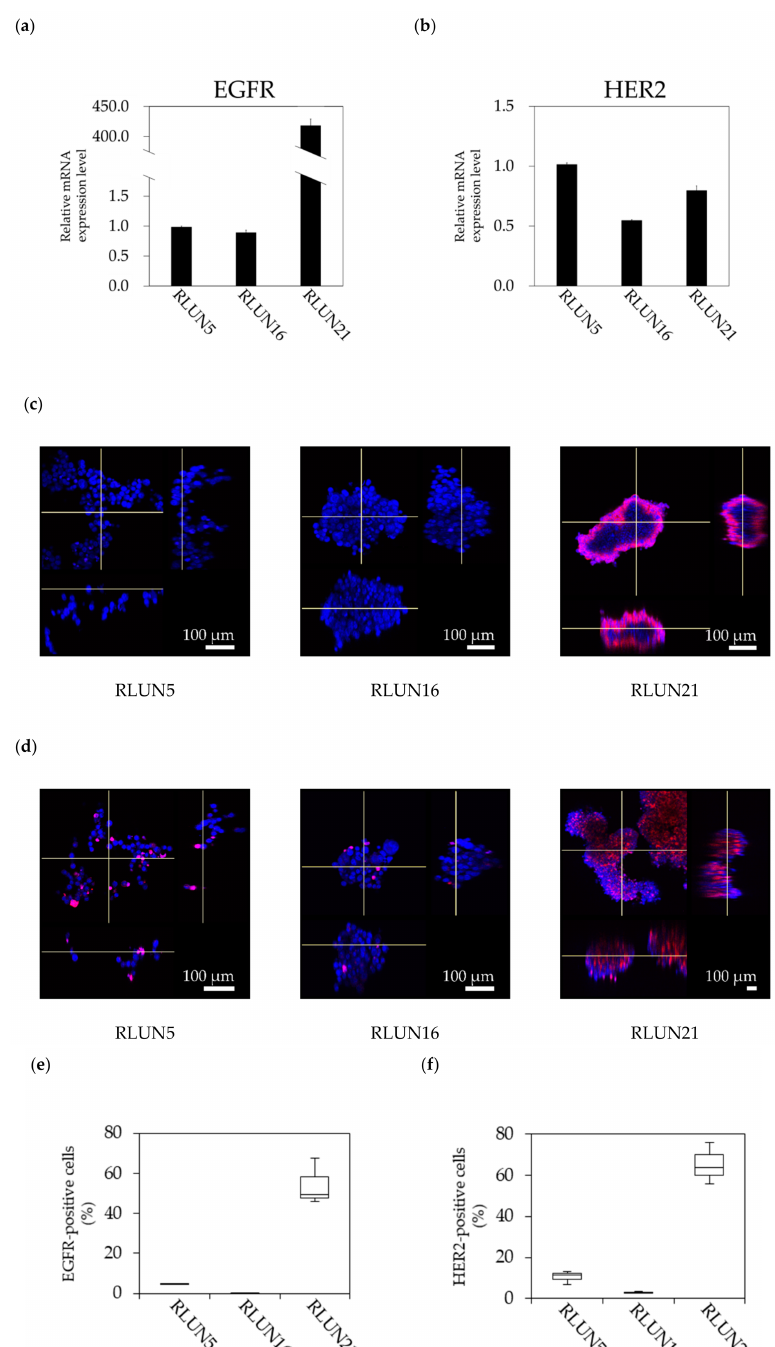
Figure 2. Expression of epidermal growth factor receptor (EGFR) and human epidermal growth factor receptor 2 (HER2) in three lung F-PDOs. mRNA-expression levels of ( a ) EGFR and ( b ) HER2 in RLUN5, RLUN16, and RLUN21. Gene-expression levels were normalized against that of 18S rRNA gene, using the 2 − ∆∆ Ct method. The expression data for RUNL16 and RUNL21 were normalized to those for RLUN5, which was set to 1. The error bars indicate the standard deviation from three replicate samples. ( c ) EGFR-expression images of RLUN5, RLUN16, and RLUN21 stained with fluorescently labeled cetuximab (red). ( d ) HER2-expression images stained with fluorescently labeled trastuzumab (red). DNA stained with DAPI (blue). Magnification: × 10. Scale bar: 100 µ m. Box-and-whisker plots of the ratio of cells positive for EGFR ( e ) or HER2 ( f ), calculated as 100 × volume of positive cells / volume of cells in a